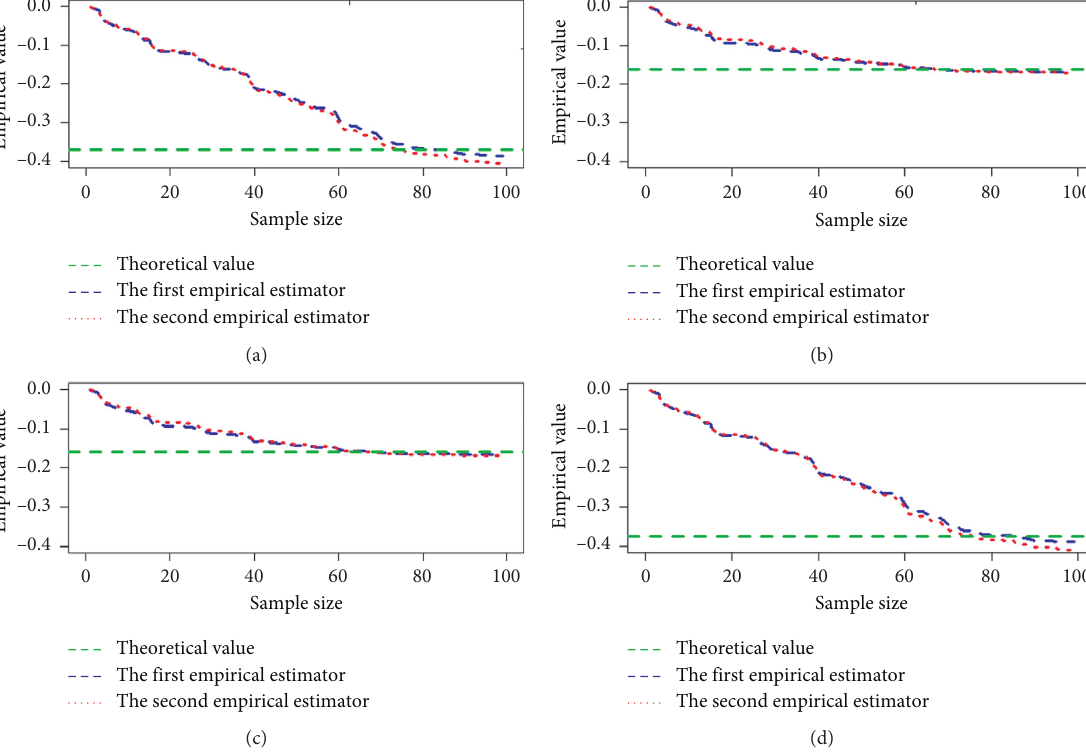
Figure 3: Empirical estimators of simulated data. (a) α � 0 . 8 ,n � 100 , r � 90. (b) α � − 0 . 8 ,n � 100 , r � 90. (c) α � 0 . 8 ,n � 100 , r � 10. (d) α � − 0 . 8 , n � 100 ,r �